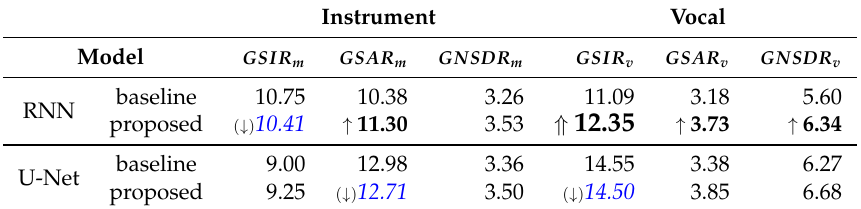
Table 3. Separation performance comparison for ccMixter dataset. Notations are same as in Table